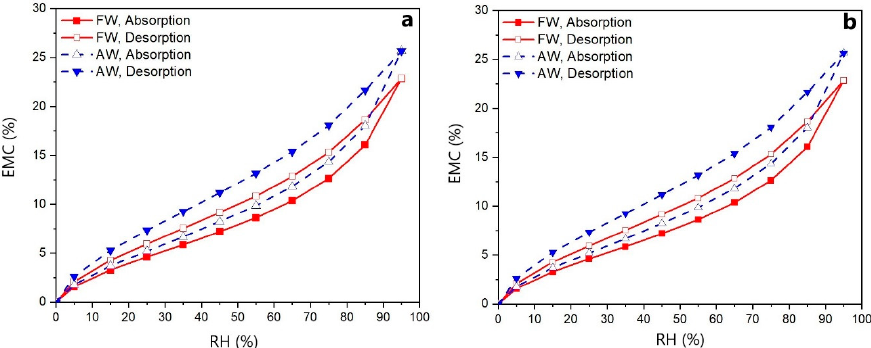
Figure 4. Adsorption and desorption isotherms of archaeological and fresh elm ( a ) and poplar ( b ) at a given relative humidity (RH) level.